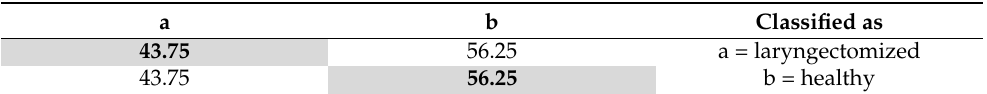
Table 11. Error matrix for the classification of the first phonetic segment. Used k-NN, cross-validation method (k = 10). General recognition 50%.